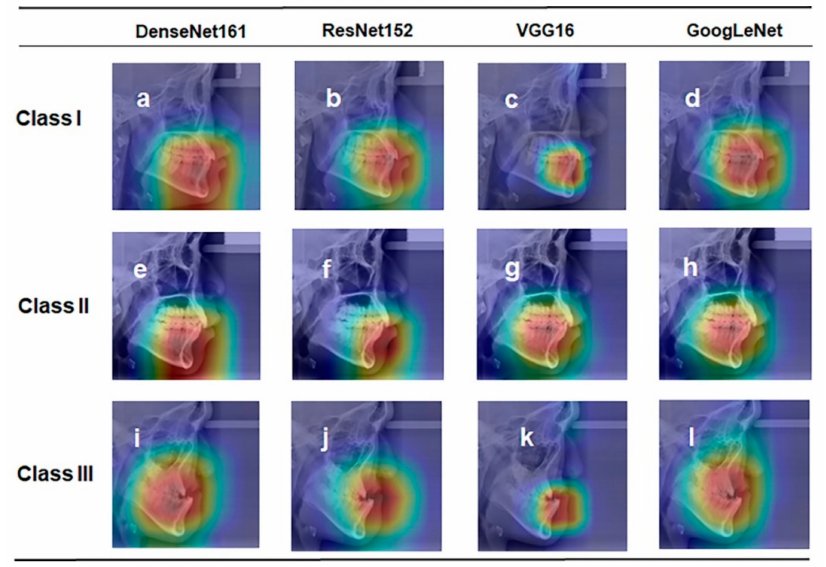
Figure 5. Representative class activation maps of different CNNs; ( a – d ) representative images of Class I; ( e – h ) representative images of Class II; ( i – l ) representative images of Class